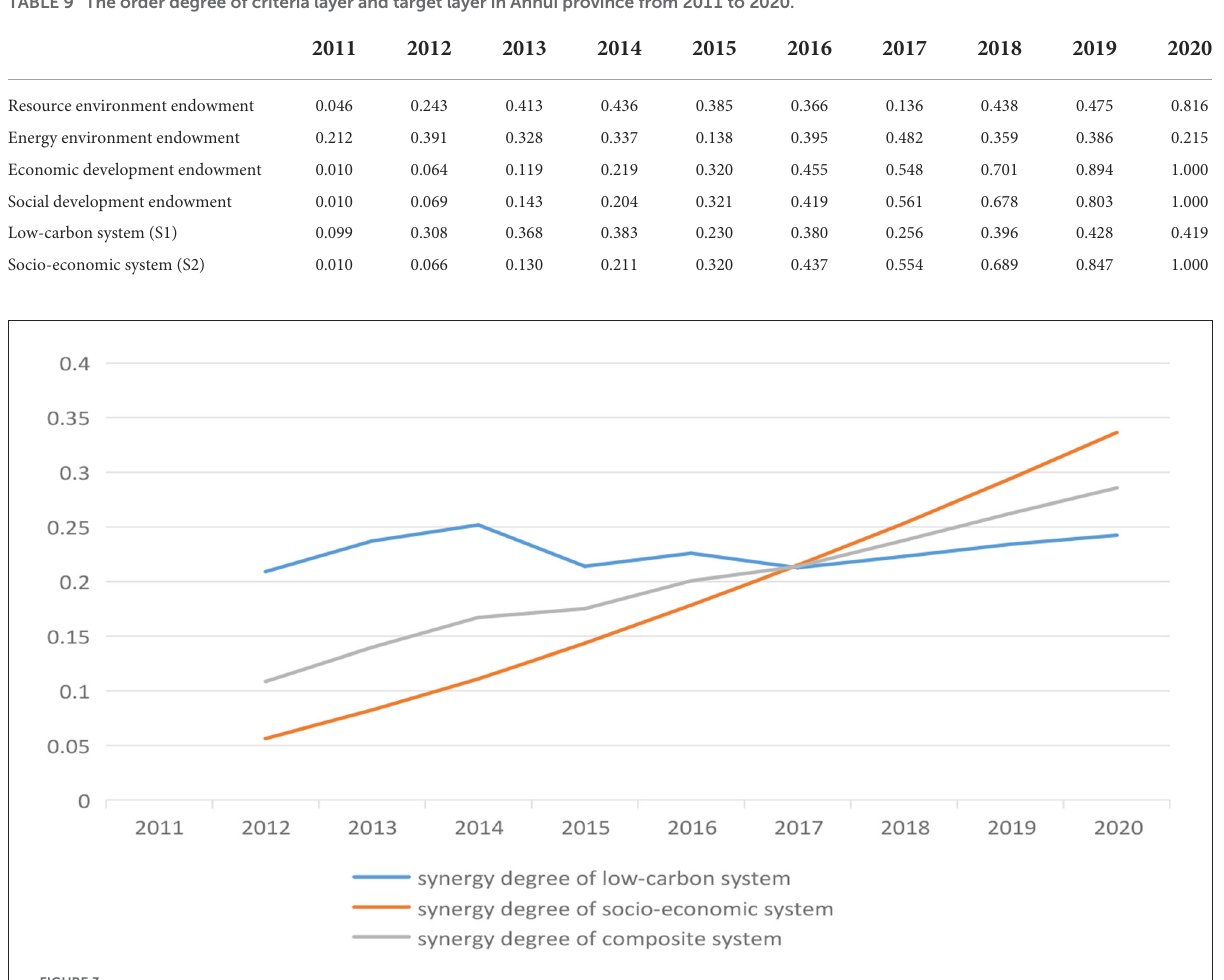
FIGURE3 The trend of synergy degree between low-carbon development and socio-economic development in Anhui